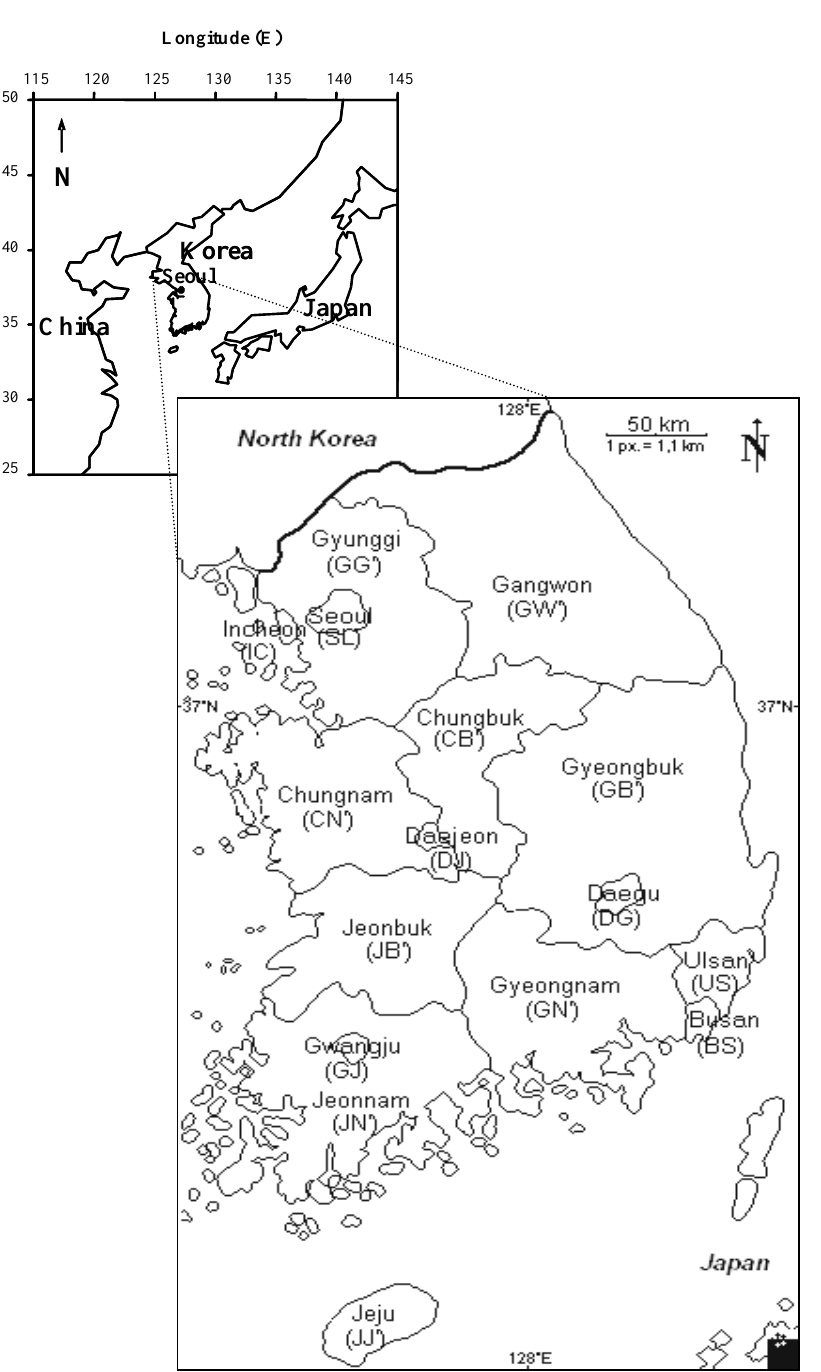
FIGURE 1. Geographical location of seven metropolitan cities (SL, BS, DG, IC, DJ, GJ, and US) and eight provinces (GW, GG, GN, GB, JN, JB, CN, and CB) in Korea.